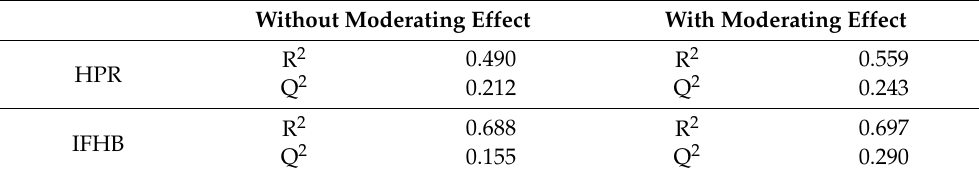
Table 7. The coefficient of determination (R 2 ) and cross-validated redundancy (Q 2 ) values of the structural results.